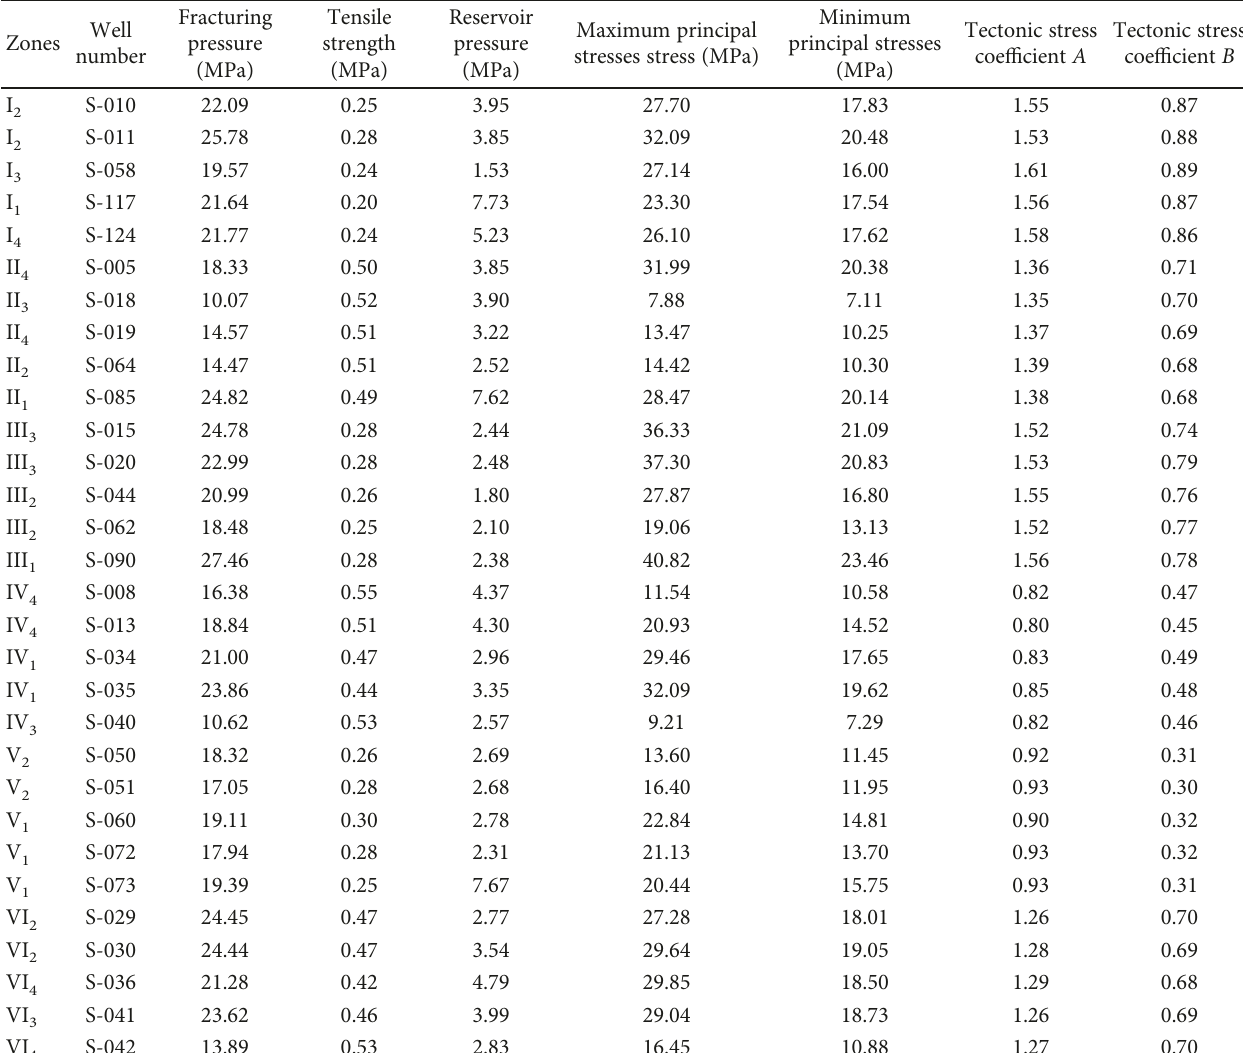
Table 2: The maximum and minimum principal stresses of partial CBM wells in di ff erent structural superposition zones. Zones